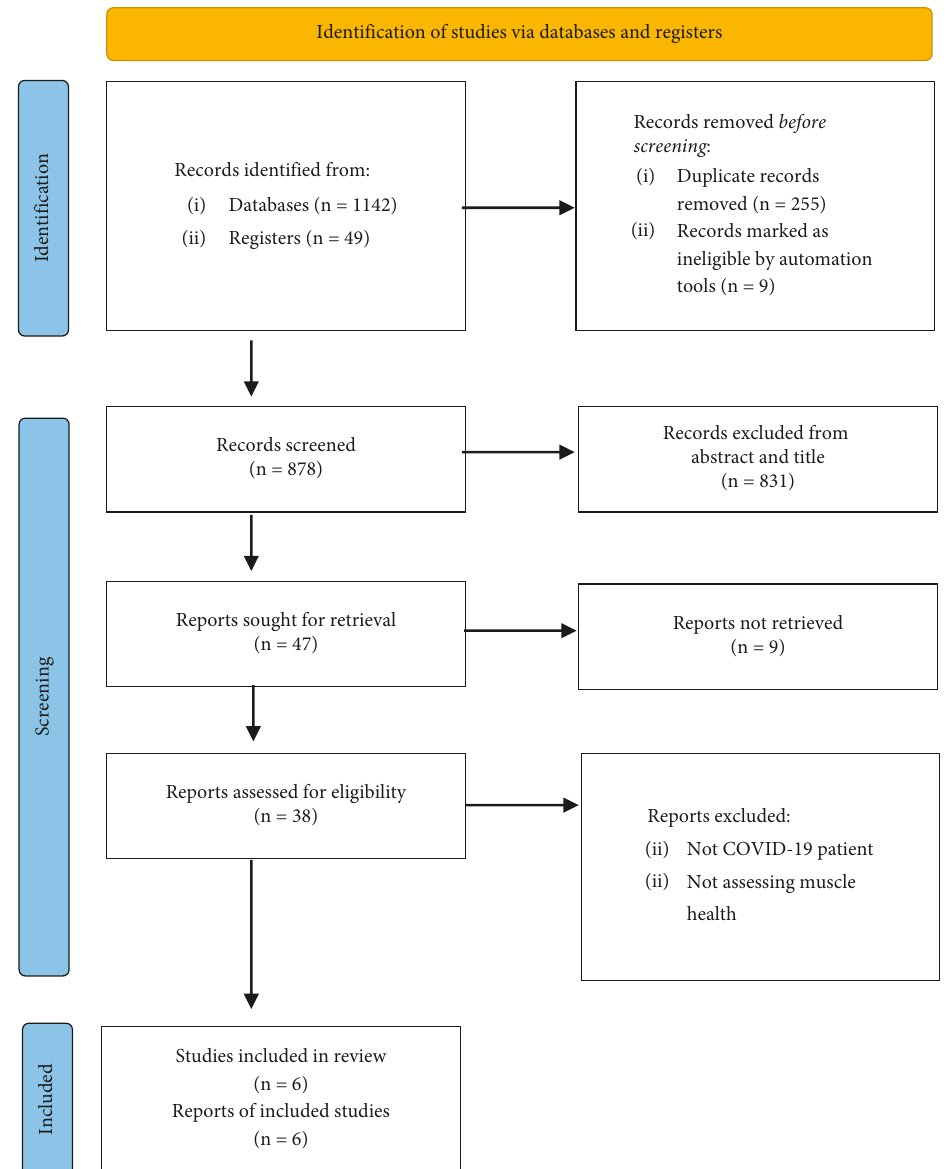
Figure 1: Flowchart of search